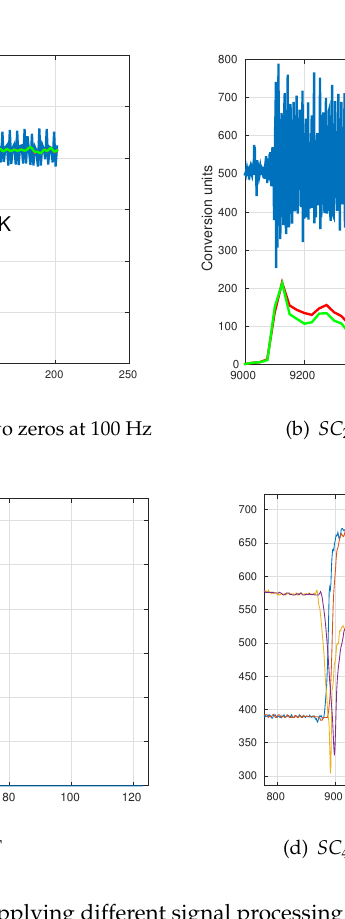
Figure 6. Output results after applying different signal processing techniques: ( a ) SC 1 : a double-zero low pass filter to remove lighting interference at 100 Hz ( F s = 250 Hz); ( b ) SC 2 : an audio signal acquired at 4 kHz and its energy obtained by using a block class of length 50 and hop size equal to 25; ( c ) SC 3 : the FFT applied to a one-channel stream of data at 250 Hz and 64 frequency bins; ( d ) SC 4 : two 50-tap polyphasic low pass filters with a decimation factor of 4 applied to data sent by a two-axis accelerometer ( F s = 250 Hz).